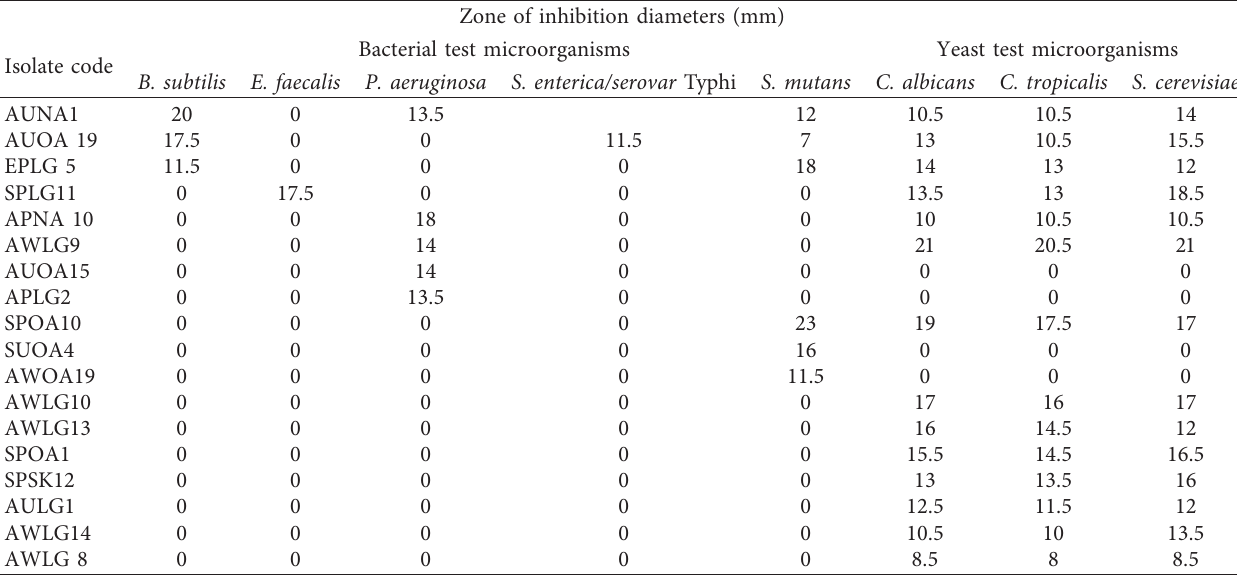
Table 3: Antimicrobial activity of the isolates against the selected test microorganisms using agar plug diffusion assay. (A) Zone of inhibition diameter of the isolates against bacterial test microorganisms and yeast test